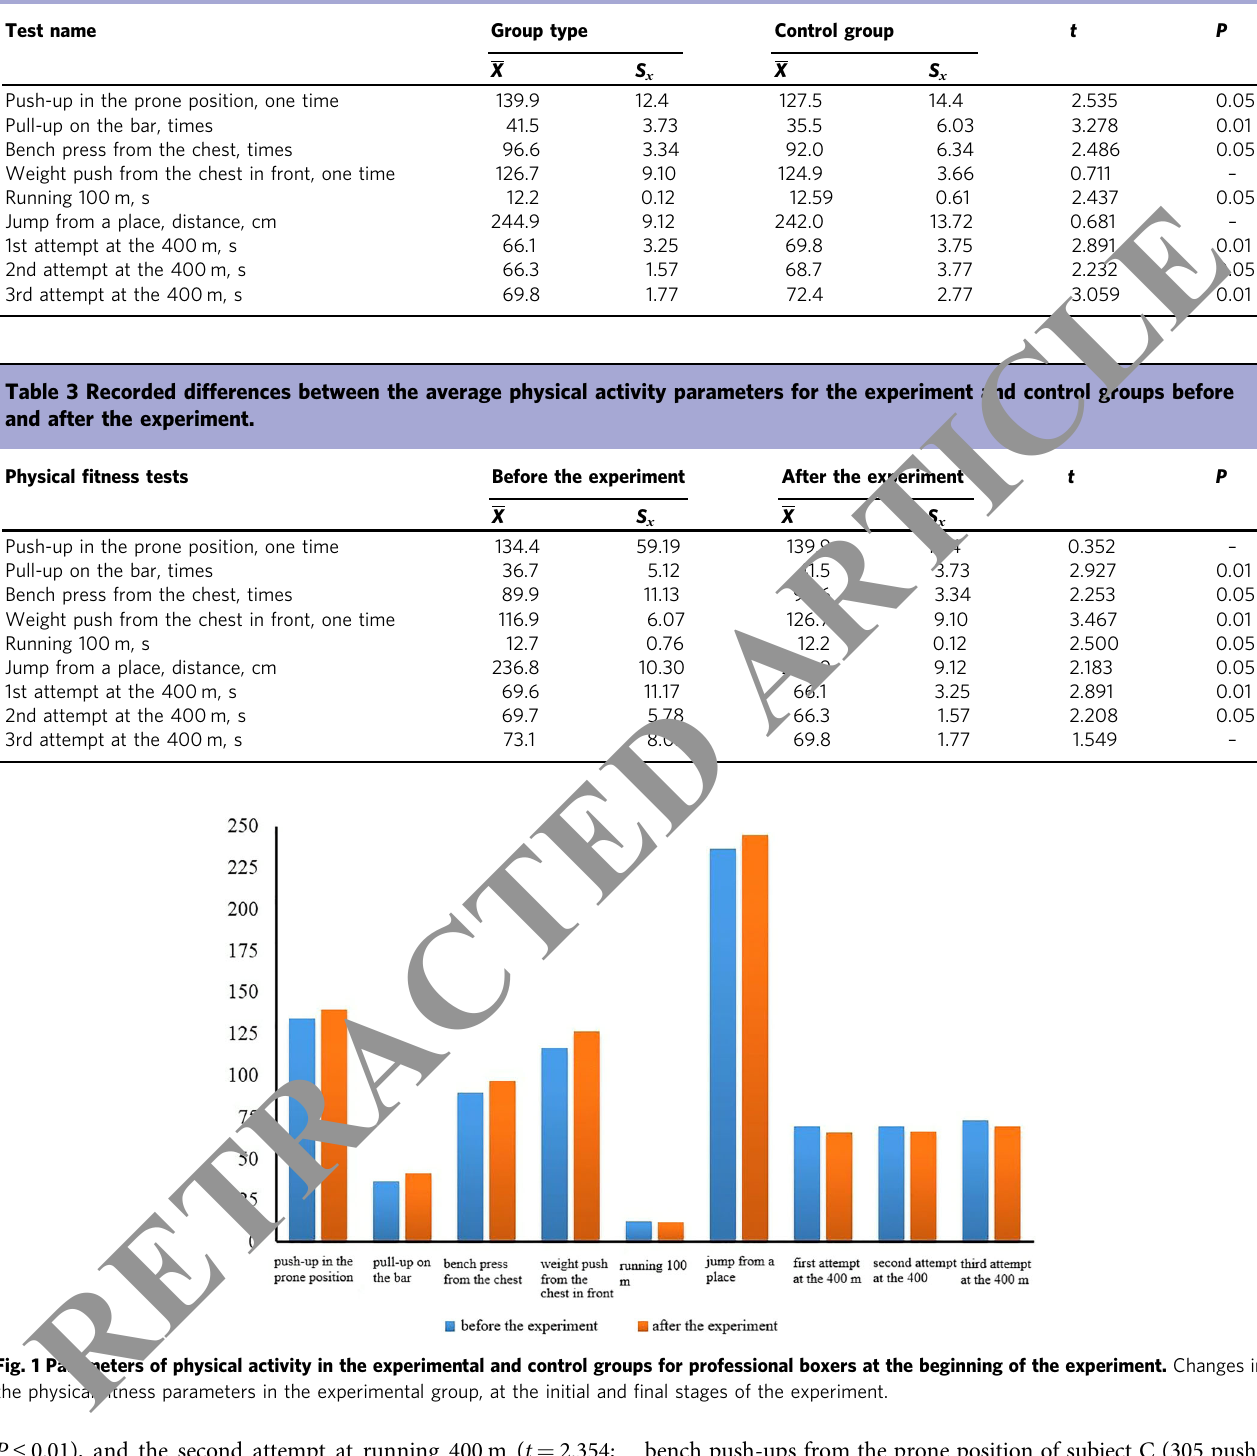
Table 2 Parameters of physical activity in the experimental and control groups for professional boxers after the experiment.